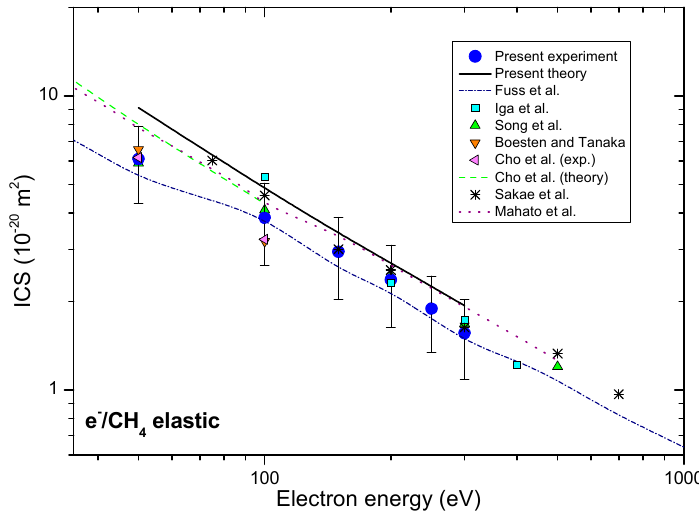
Figure 2. Integral cross-sections for elastic electron-methane collision, presented in energy range from 35 eV to 1000 eV. Present experimental (blue circles) and theoretical (solid black line) results are shown together with previous experimental, as well as the theoretical results, for comparison.